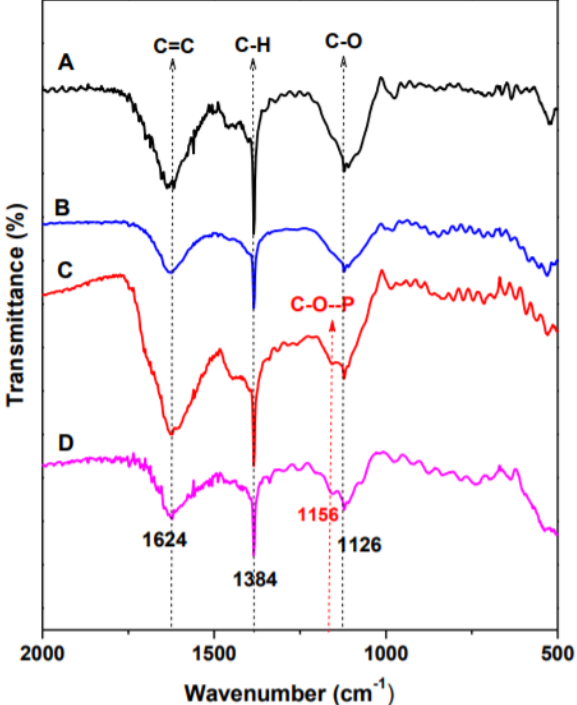
Figure 7. IR spectra of four char samples (A: Pb@Char350, B: Pb@Char450, C: Pb@PA 1.0 Char350, and D: Pb@PA 1.0 Char450).